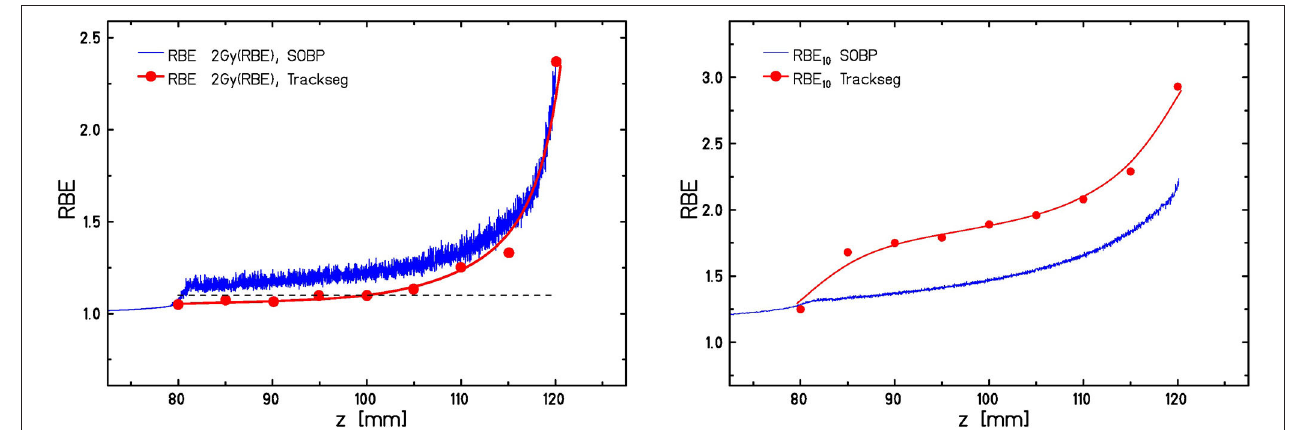
FIGURE 6 | Comparison of predicted RBE 10 values for HTB177 cells along a 40mm proton SOBP (left) and carbon SOBP (right) from 80 to 120mm with RBE 10 values expected for track segment conditions (i.e., monoenergetic beams) at the same dose mean LET. The dashed line in the left panel indicates the RBE of 1.1, which is currently used in treatment planning for proton